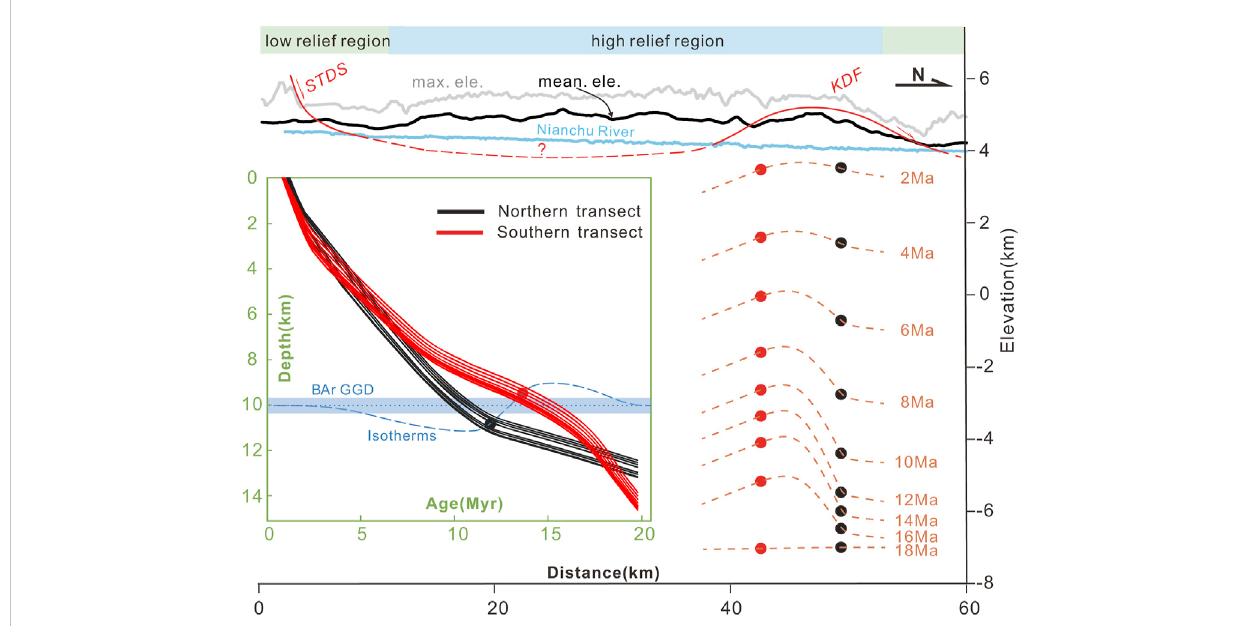
FIGURE 9 Topographic pro fi les, averaged equilibrium line altitudes (ELAs), and exhumation patterns (depth isochrones) along a south ‒ north swath across the Kangmardome.TheswathispartofFigure2B.Thecurvesinthegreenboxrepresentthedepth ‒ timepathofthetwotransectsgeneratedfromtheirbest- fi t model, note that the blue dotted line represents the isotherms (assuming that the south portion takes the B-Ar value of ~14 Ma, the north ~12 Ma), GGD, Geothermal-Gradient Depth. The orange lines represent the depth isochrones generated from the depth ‒ time